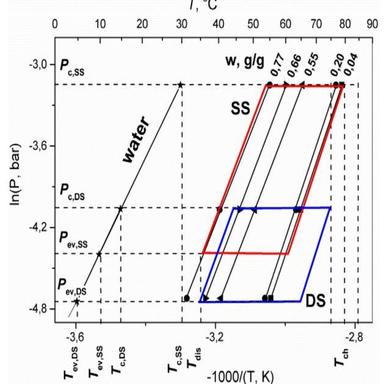
Isosters of water adsorption on the LiCl/vermiculite composite, as well as the SS (red line) and DS (blue line) TES cycles. (For interpretation of the references to color in this figure legend, the reader is referred to the web version of this article.)